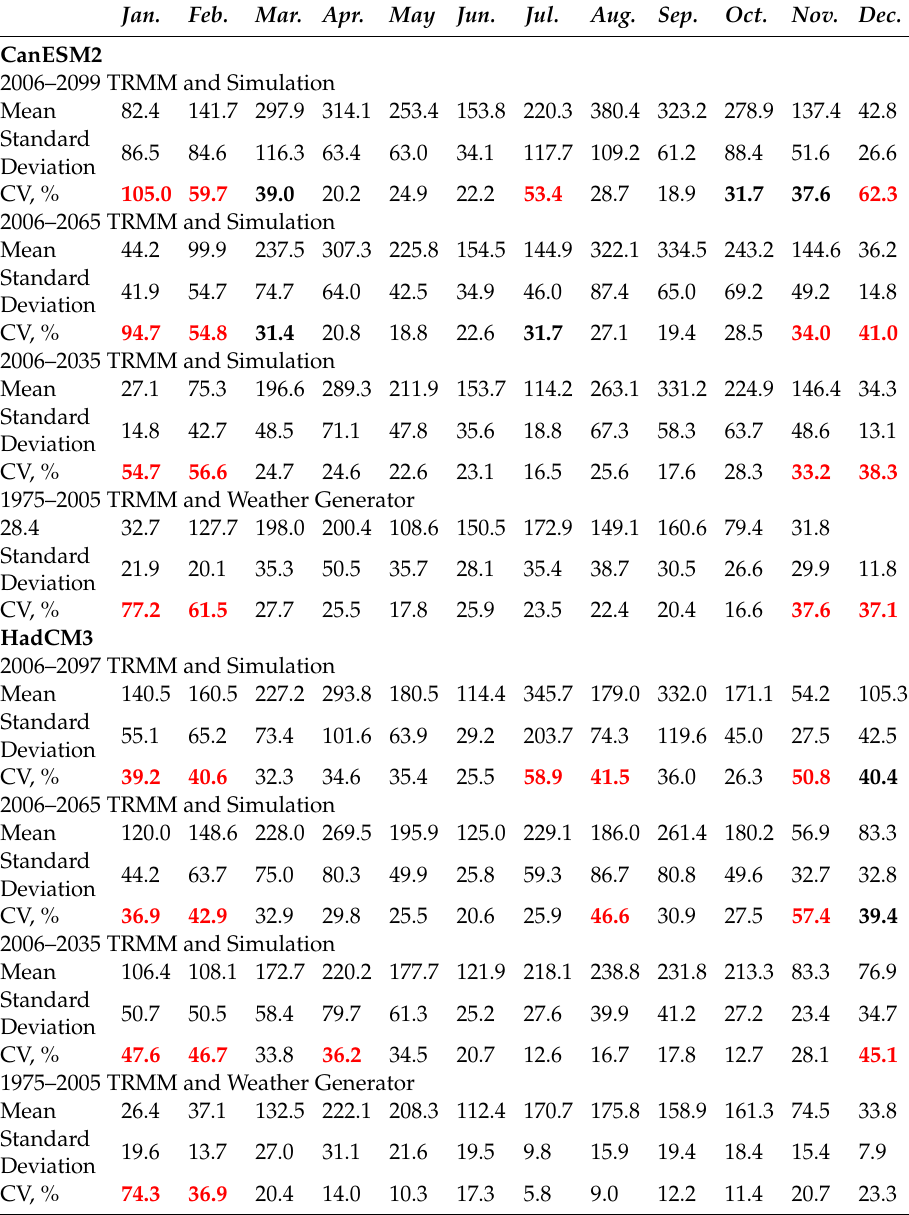
Table 8. Gulu TRMM and Simulated (CanESM2and HadCM3) Monthly Rainfall Coe ffi cient of Variation. Jan. Feb. Mar. Apr. May Jun. Jul. Aug. Sep. Oct. Nov.